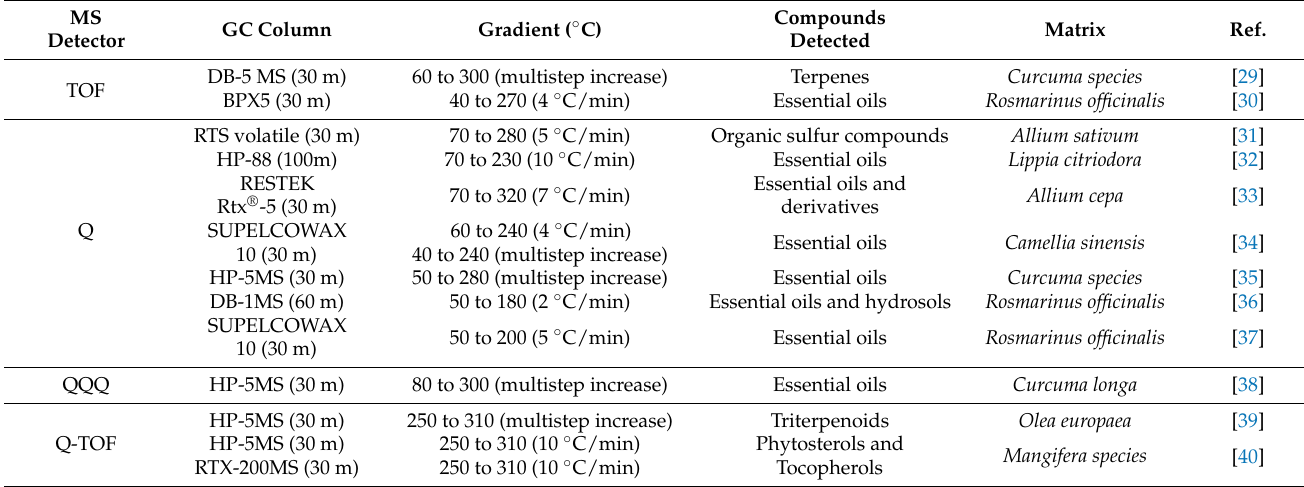
Table 1. Applications of GC–MS to characterize bioactive compound from natural